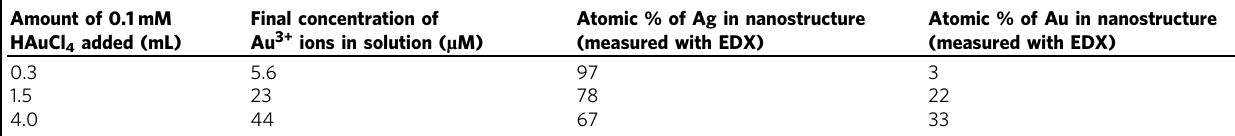
Table 1 Atomic compositions of nanostructures obtained from galvanic replacement (GR) of Ag nanocubes by Au at 90 °C Final concentration of Atomic % of Ag in nanostructure Amount of 0.1 mM Au 3+ ions in solution ( µ M) (measured with EDX) HAuCl 4 added (mL)